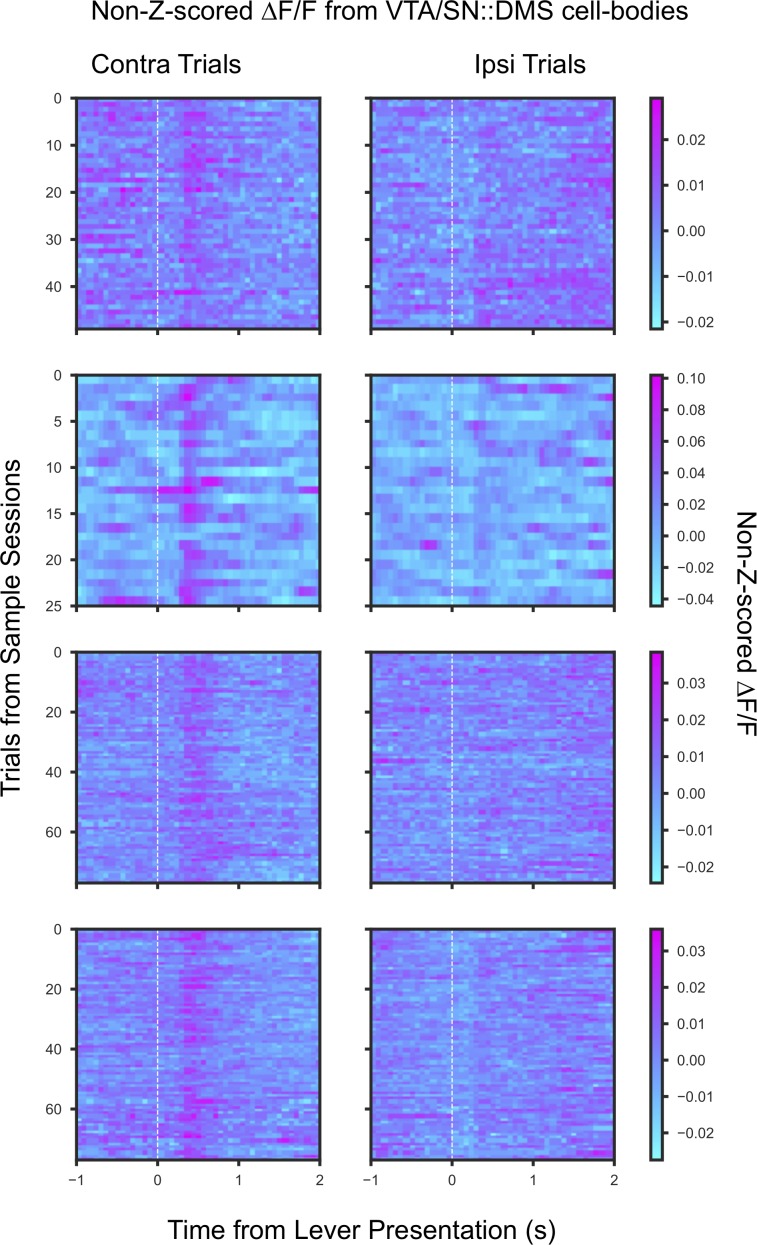
Four Examples of non-Z-scored Individual Sessions of Photometry Data from VTA/SN::DMS Cell-Bodies.Sample, not Z-scored ∆F/F recording from VTA/SN::DMS Cell-bodies. Each row is an example session from a different mouse. Traces are time-locked to the lever presentation for contralateral trials (left column) and ipsilateral trials (right column). White dotted vertical line indicate lever presentation. Colorbars are provided for each row for each example session.